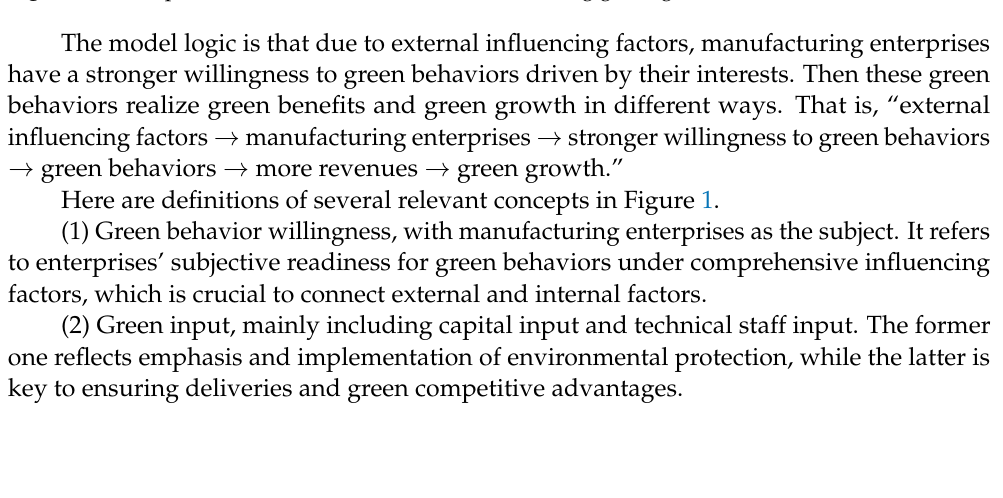
Figure 1. Conceptual model of the main factors influencing green